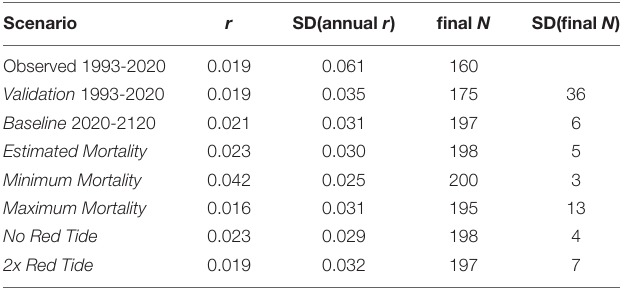
TABLE 5 | Results for scenarios projecting population growth for the Sarasota Bay population of bottlenose dolphins. Scenario